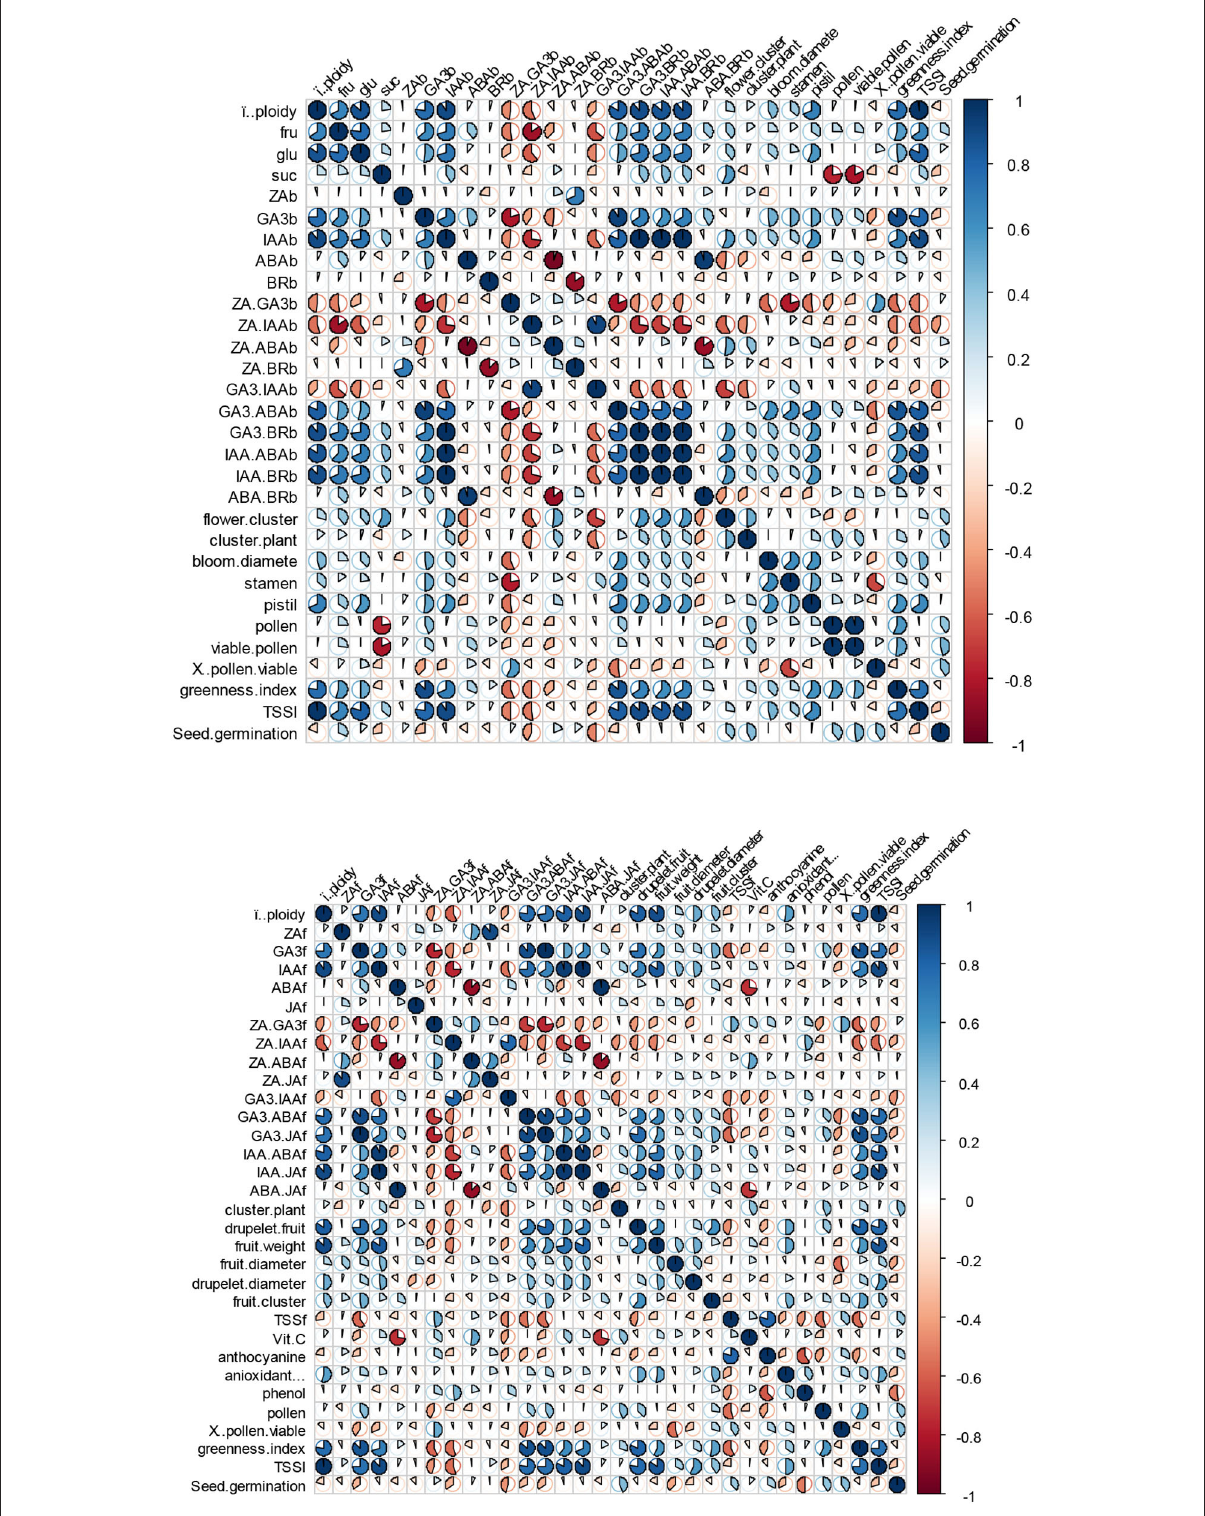
FIGURE6 Heat map for the comparison of the recorded traits during blooming (top) and fruiting (down) phases. Each cell is a Pearson’s correlation for one feature with the other. Values are reported as − 1 to 1 interval. Colors and the pie size are coded by normalized value